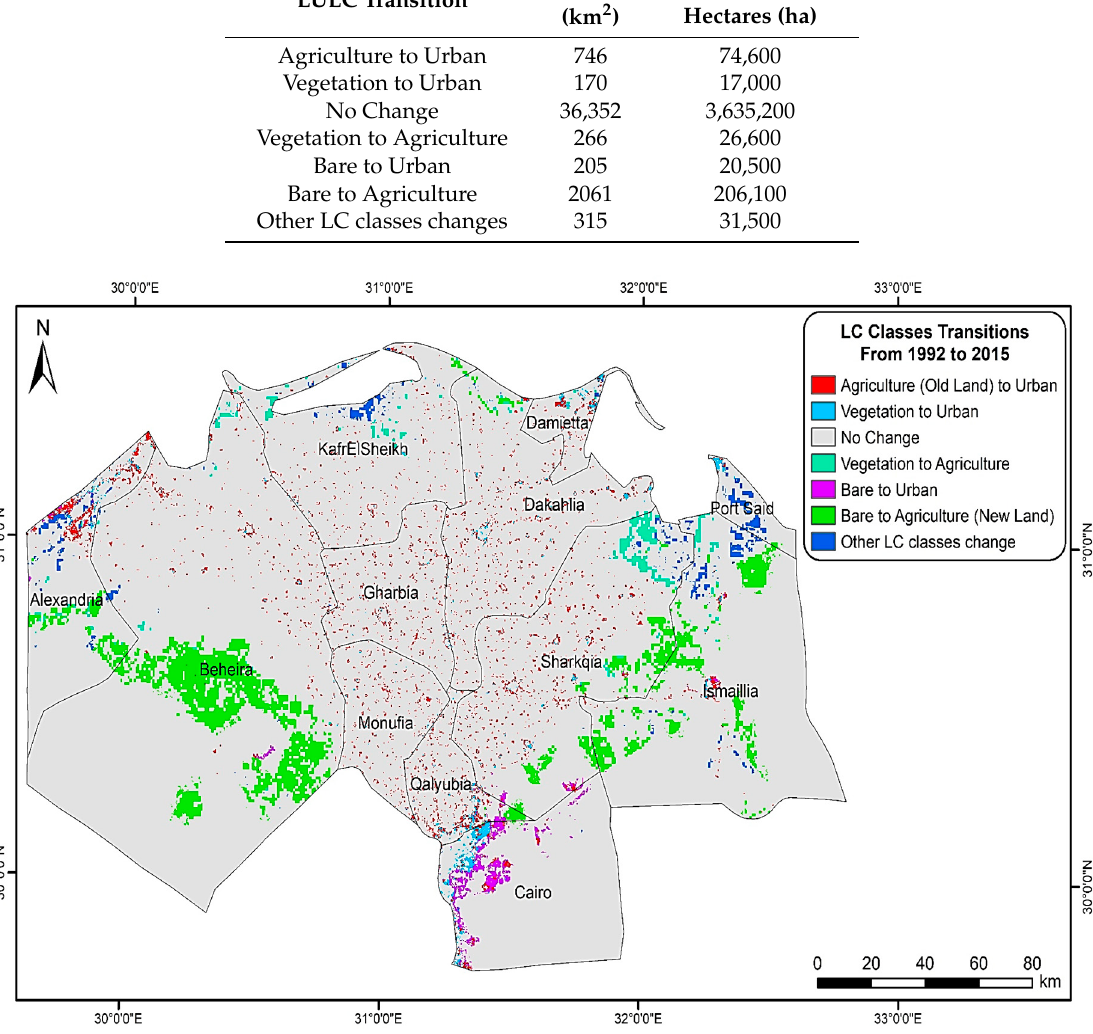
Figure 6. Change map between the 1992 and 2015 LULC distributions.